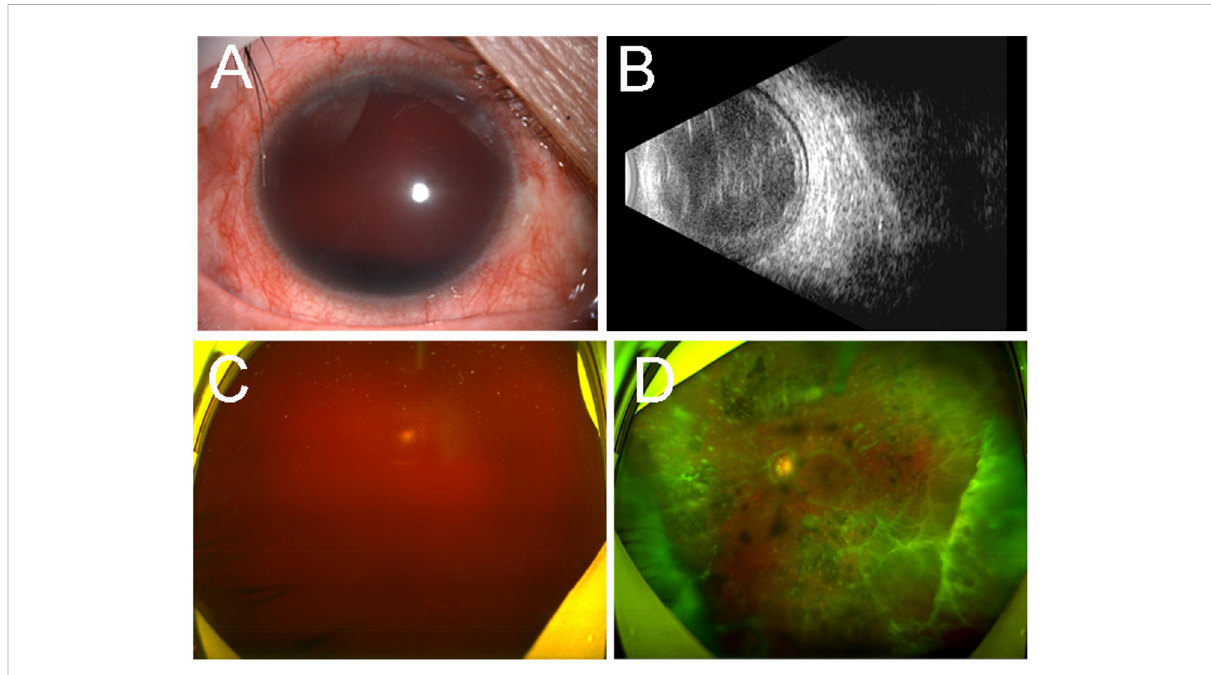
FIGURE 2 Ocular imaging fi ndings of the both eyes of the proband (III-13) four years later. Slit-lamp examination (A) revealed hyphema of the right eye. B-mode ultrasonography (B) showed mass echoes in the vitreous cavity. Ultra-wide- fi eld scanning laser ophthalmoscopy revealed vitreous hemorrhage in the right eye (C) and multiple fl occulent degenerations in the vitreous of the left eye (D)